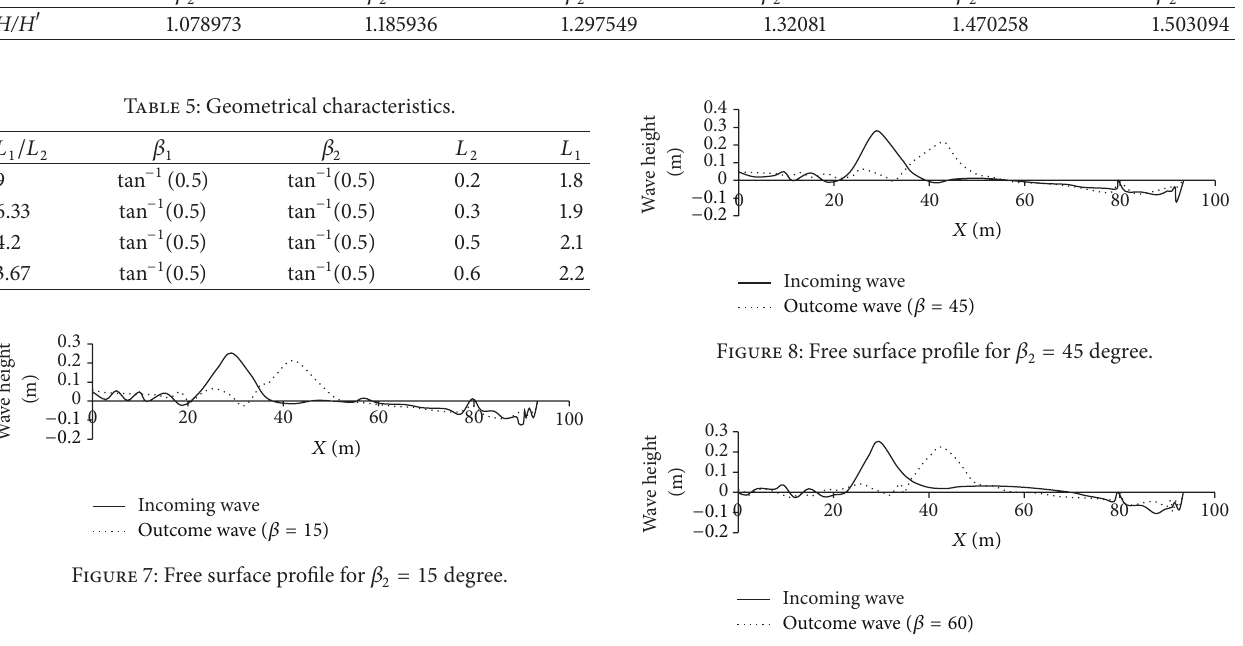
Figure 9: Free surface profile for 𝛽 2 = 60 degree.